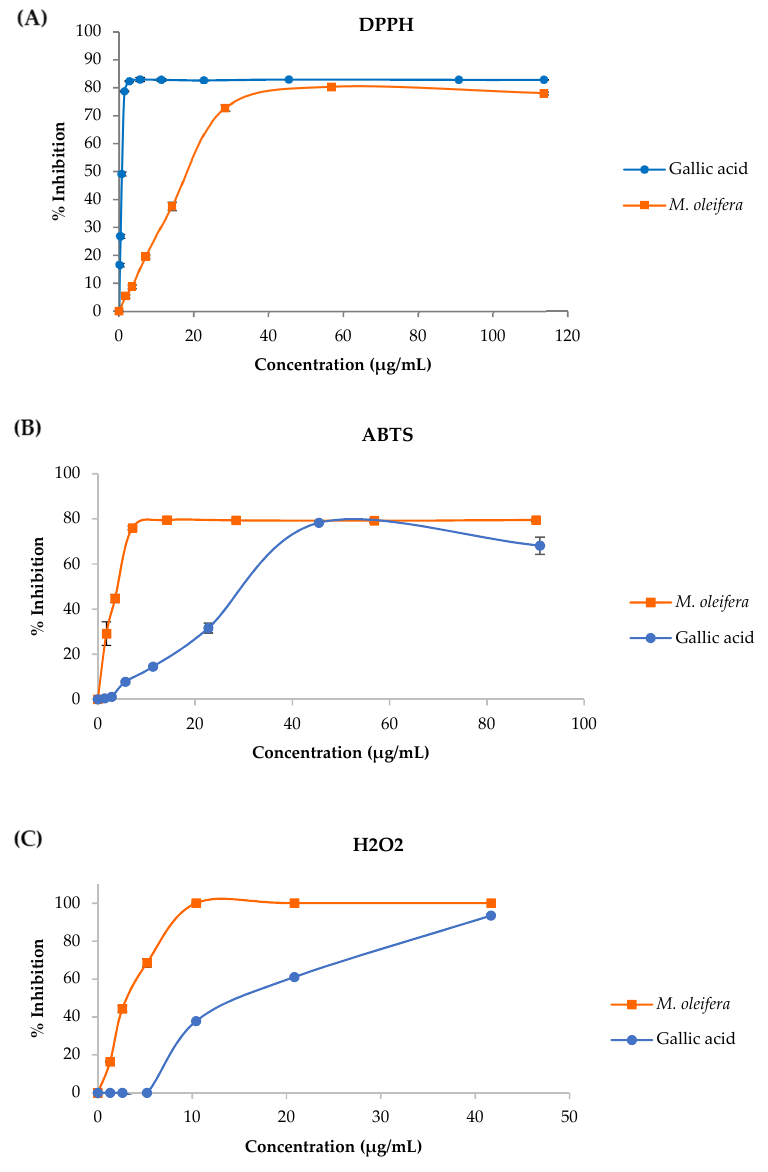
Figure 2. Percent inhibition of DPPH ( A ), ABTS ( B ), and H 2 O 2 ( C ) of M. oleifera leaf tea. Data are mean values ± standard error (error